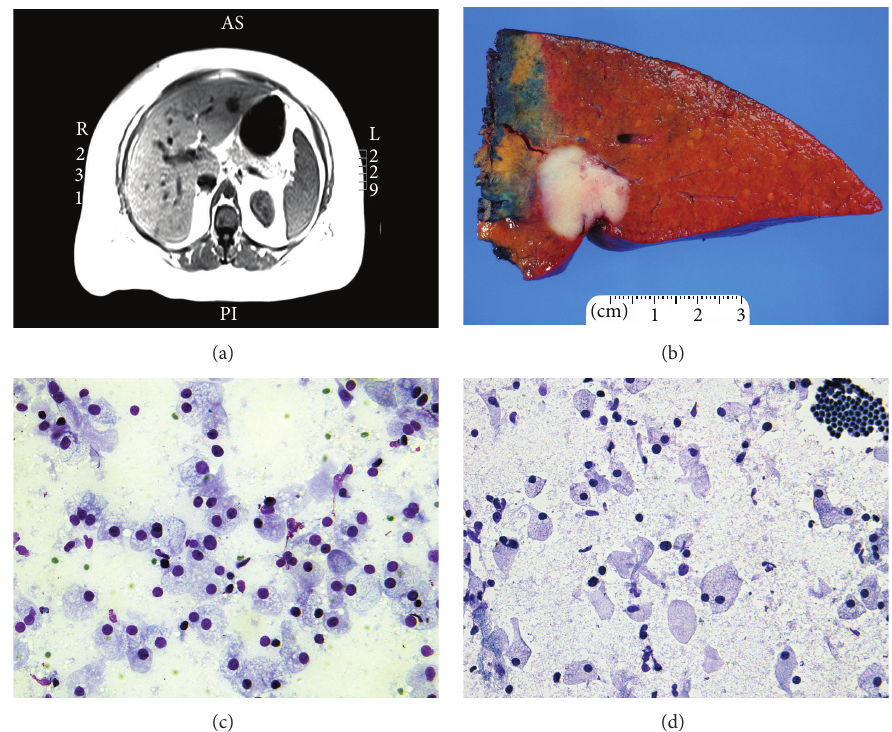
Figure 1: Radiologic, macroscopic, and cytologic features of intrahepatic clear cell bile duct adenoma. (a) Axial T1-weighted MRI scan of the abdomen demonstrating a hypointense lesion in the left lateral segment of the liver. (b) Segmental hepatectomy specimen showing a tan-white well circumscribed subcapsular tumor measuring 2.8 × 2.2 × 2.0 cm. (c-d) Diff-Quick (c) and ultrafast Papanicolaou (d) stained cytologic smears of tumor cells (c-d, ×